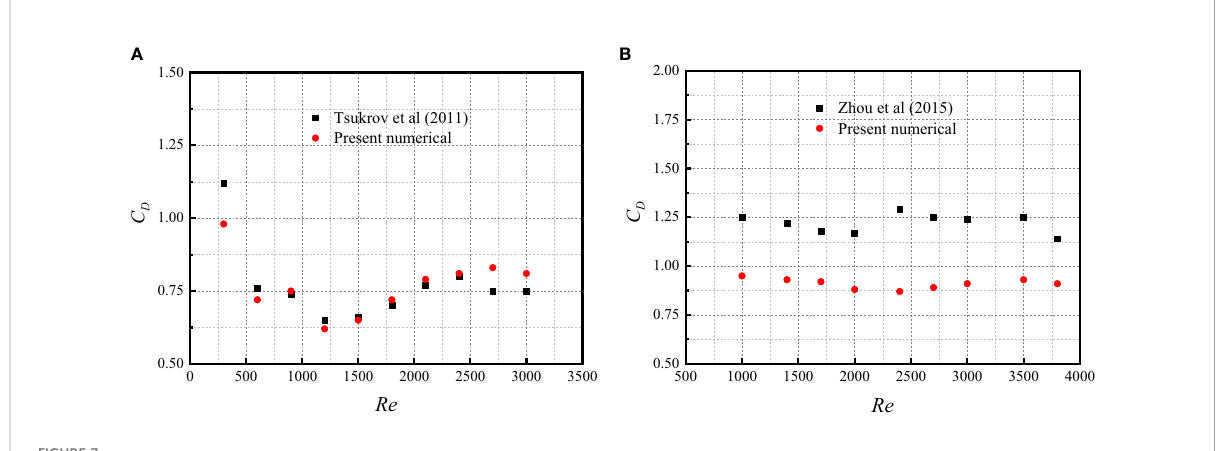
FIGURE 7 The dependence of drag coef fi cient on the Reynolds number. (A) Drag coef fi cients of the yellow brass ChainLink diamond netting. (B) Drag coef fi cients of four-strand braided diamond